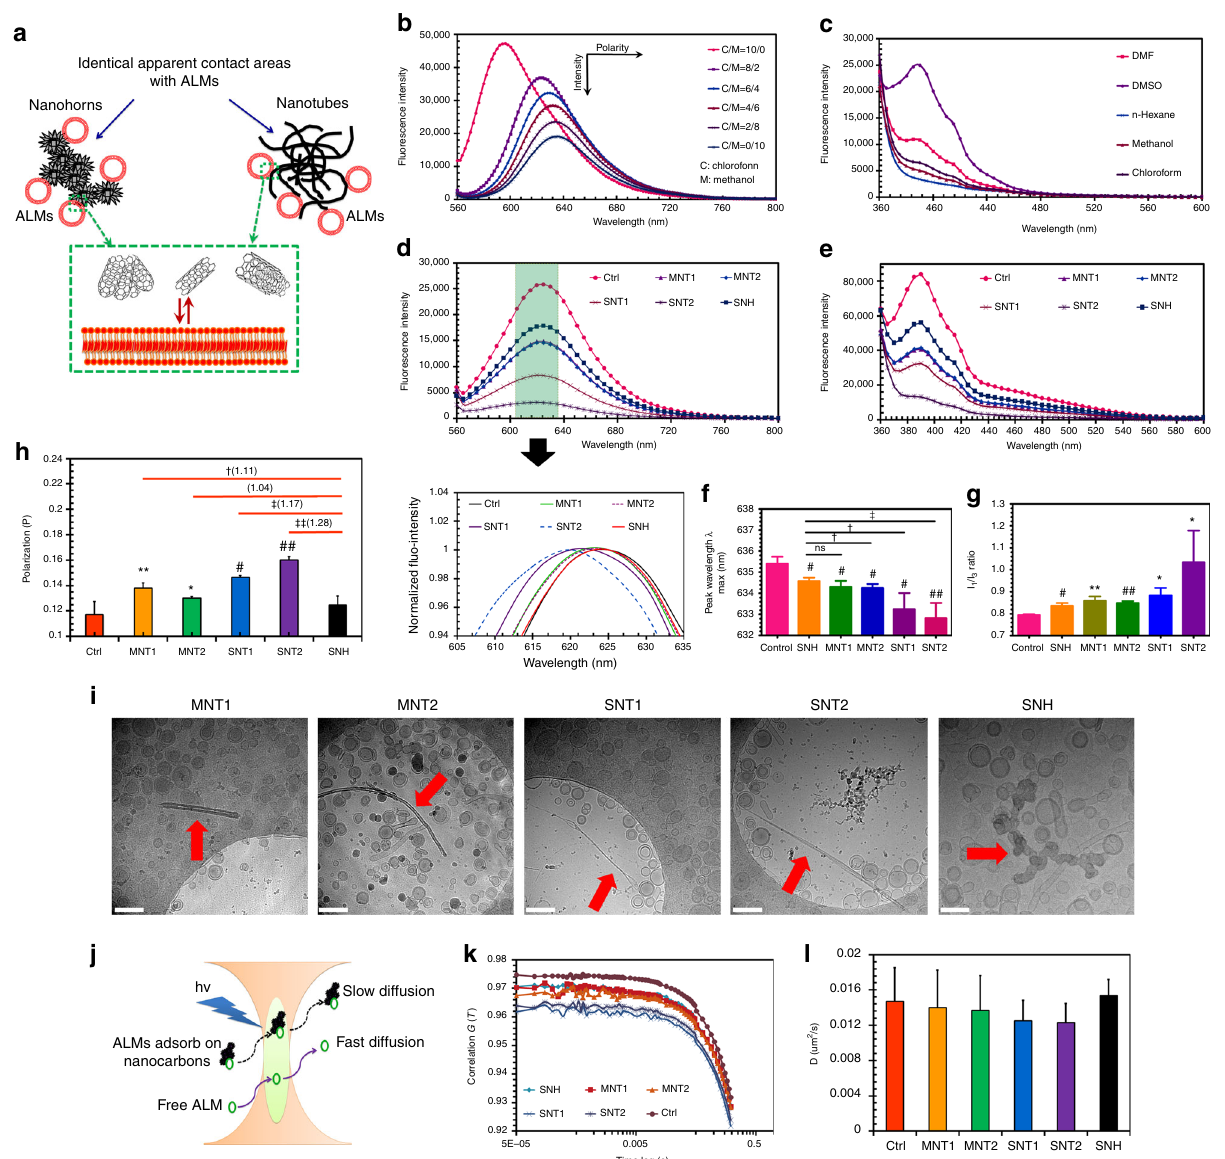
Fig. 7 SNH brought lower membrane disturbance than CNT. a Schematic of membrane interactions induced by different nanocarbons. Arti fi cial lipid membranes (ALMs) were fabricated in the investigations. Since nanocarbons usually assembled in aqueous medium, the mass concentrations of fi ve nanocarbons were modulated to keep the identical apparent contact area, which was calculated based on hydrodynamic radius (R H ). b , c Fluorescence spectrums of two environment sensitive probes, b nile red and c pyrene in solvents with different polarities. d , e Fluorescence spectrums of ALMs labeled with d nile red and e pyrene respectively after different nanocarbon incubations. The insets represented the normalized spectrums of fl uorescent ALMs near emission peaks. f The comparison of λ max after the incubation of nanocarbons with ALMs. Three independent spectrum scanning were performed in each experiment group. g The quantitative detection of I 1 / I 3 after nanocarbon incubation based on the spectrum scanning of pyrene-labeled ALMs ( n = 3). h Polarization ( P ) measurements of ALMs labeled with DPH after the incubations of different nanocarbons ( n = 4). i Cryo-transmission electron microscopy images of ALMs after different nanocarbon incubations. Red arrows showed the nanocarbons in aqueous medium. Scale bar: 100 nm. j Schematic of fl uorescence correlation spectroscopy (FCS). Fluorescent ALMs that bound with nanocarbons could be distinguished from free ALMs by FCS because of the reduced diffusion rates. k Autocorrelation curves of ALMs after nanocarbon incubations detected by FCS. l Diffusion coef fi cient detection of ALMs after different nanocarbon incubations based on autocorrelation curve fi tting ( n = 12). In f , g , h , and l , data were presented as means ± s. d. Statistical signi fi cances were calculated by Student ’ s t -test. Data were compared with control (Ctrl) and SNH groups respectively. Versus Ctrl: * p < 0.05, ** p < 0.01, # p < 0.005, ## p < 0.001. Versus SNH: † p < 0.05, †† p < 0.01, ‡ p < 0.005, ‡‡ p < 0.001. The values in brackets denoted the data ratios compared